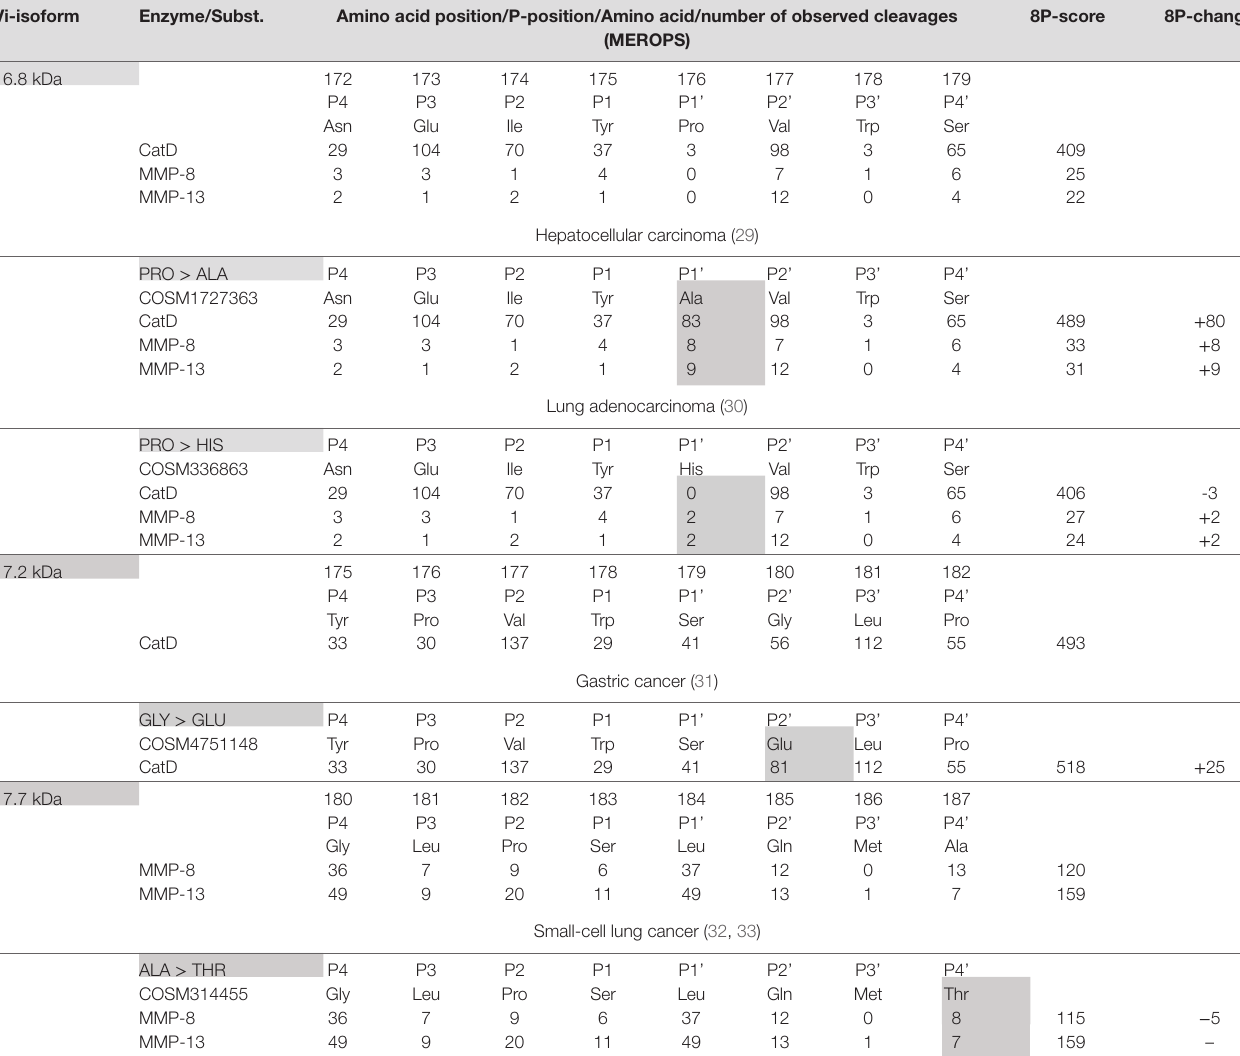
TaBle 2 | Effect of single amino acid substitutions observed in cancer on vasoinhibin isoforms generation. Vi-isoform